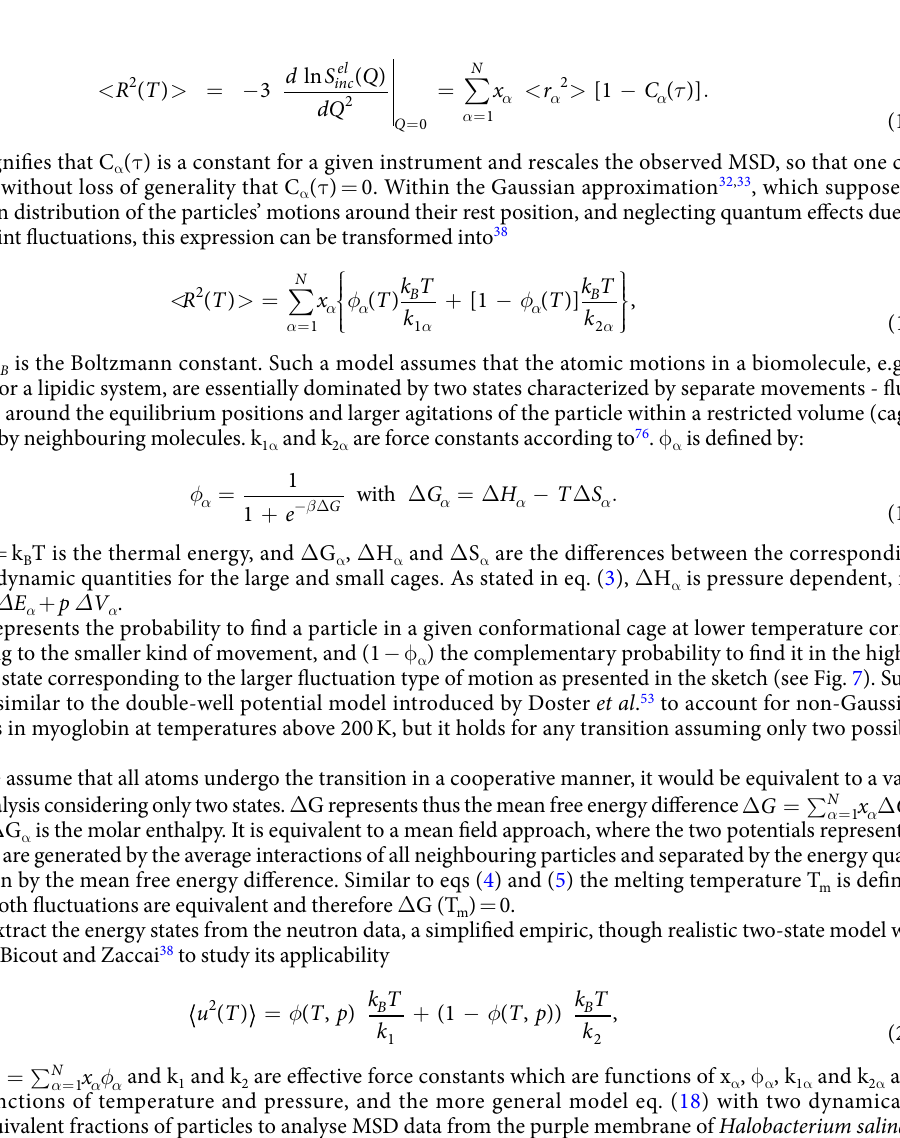
Figure 7. Sketch of the two potentials corresponding to the smaller and larger fluctuations. The width of each well is a qualitative indication of the root-mean-square fluctuation, u 2 , and of the entropy of the corresponding